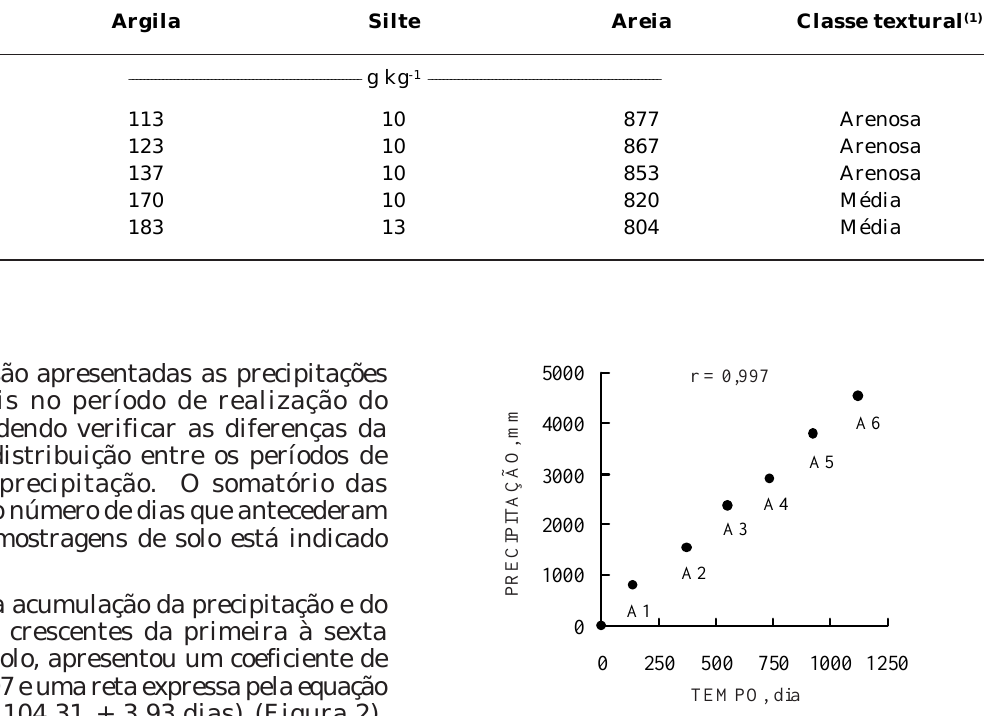
Figura 2. Acumulação das precipitações pluviais mensais de acordo com a acumulação do nú- mero de dias, para cada uma das seis amostragens no período do experimento de 20/ 10/1999 a 20/10/2002. A1 a A6 correspondem ao somatório das precipitações e do número de dias que antecederam cada uma das seis amostragens de solo apresentadas na figura